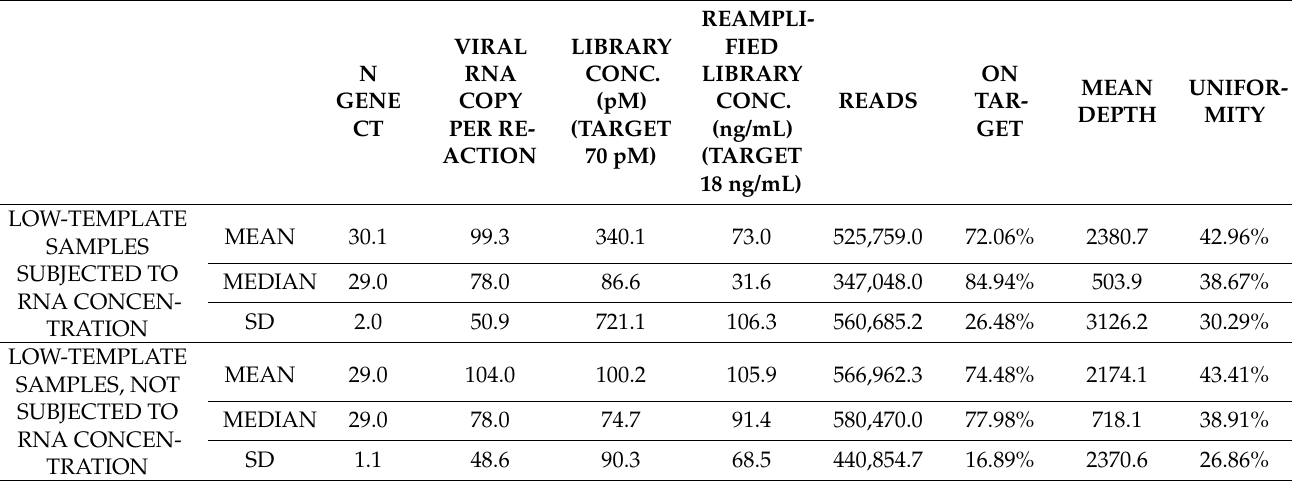
Table 2. Results of concentration of low-template RNA isolates